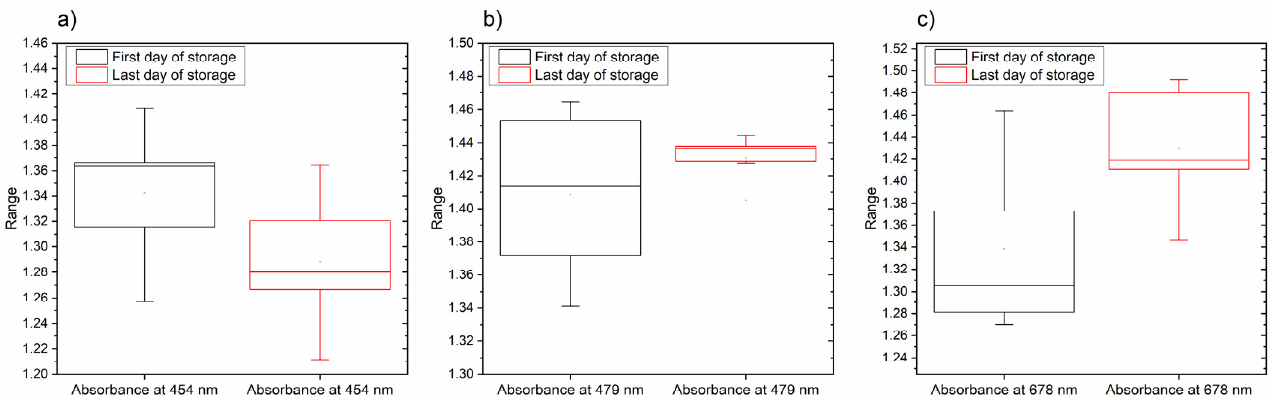
Figure 4. Comparison of values of absorbance at absorbance bands corresponding to the identified main pigments in lettuce leaves—454 nm ( β -carotene), 479 nm (Chl b) and 678 nm (Chl a): ( a ) values of absorbance at 479 nm; ( b ) values of absorbance at 454 nm; ( c ) values of absorbance at 678 nm. The absorbance values are averages from the spectra of lettuce leaves acquired on the first and last day of storage.